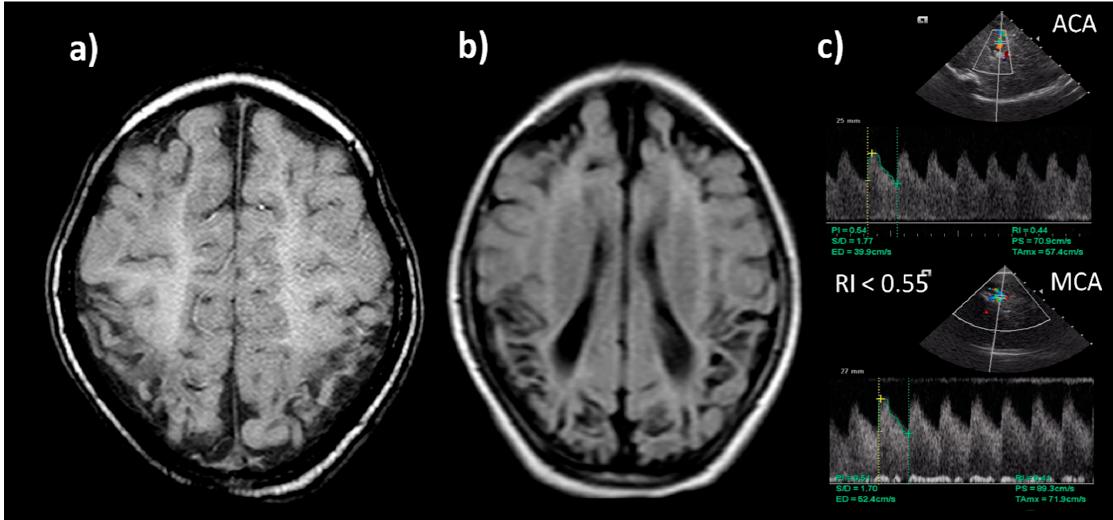
Figure 6. ( a ) High cerebral oxygenation on NIRS * with ( b ) a low-electrical-activity aEEG background ** in severe HIE neonates on hypothermia treatment at 12 h of age has a 91%positive predictive value for long ‐ term adverse neurological outcome (magnetic resonance imaging and neuro ‐ developmental assessment at 18 months of age), and the absence of these results in a negative pre ‐ dictive value of 100%. NIRS: near infrared spectroscopy; aEEG: amplitude-integrated electroencephalography; rScO 2 : regional cerebral oxygenation; cFTOE: cerebral fractional tissue oxygen extrac ‐ tion. Courtesy: Daniel Ibarra ‐ Ríos, MD, Department of Neonatology, Hospital Infantil de México